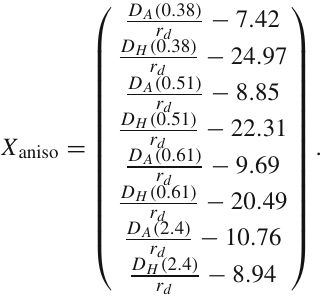
tours corresponds to value of α = 1 [77]. The parameter α cannot be constrained from the present observational data we have considered here. A confidence contour is shown in ( 0 ) Fig. 10 in the α − (cid:13) m parameters space from where it is evident that the present data is unable to put any bound on the parameter α